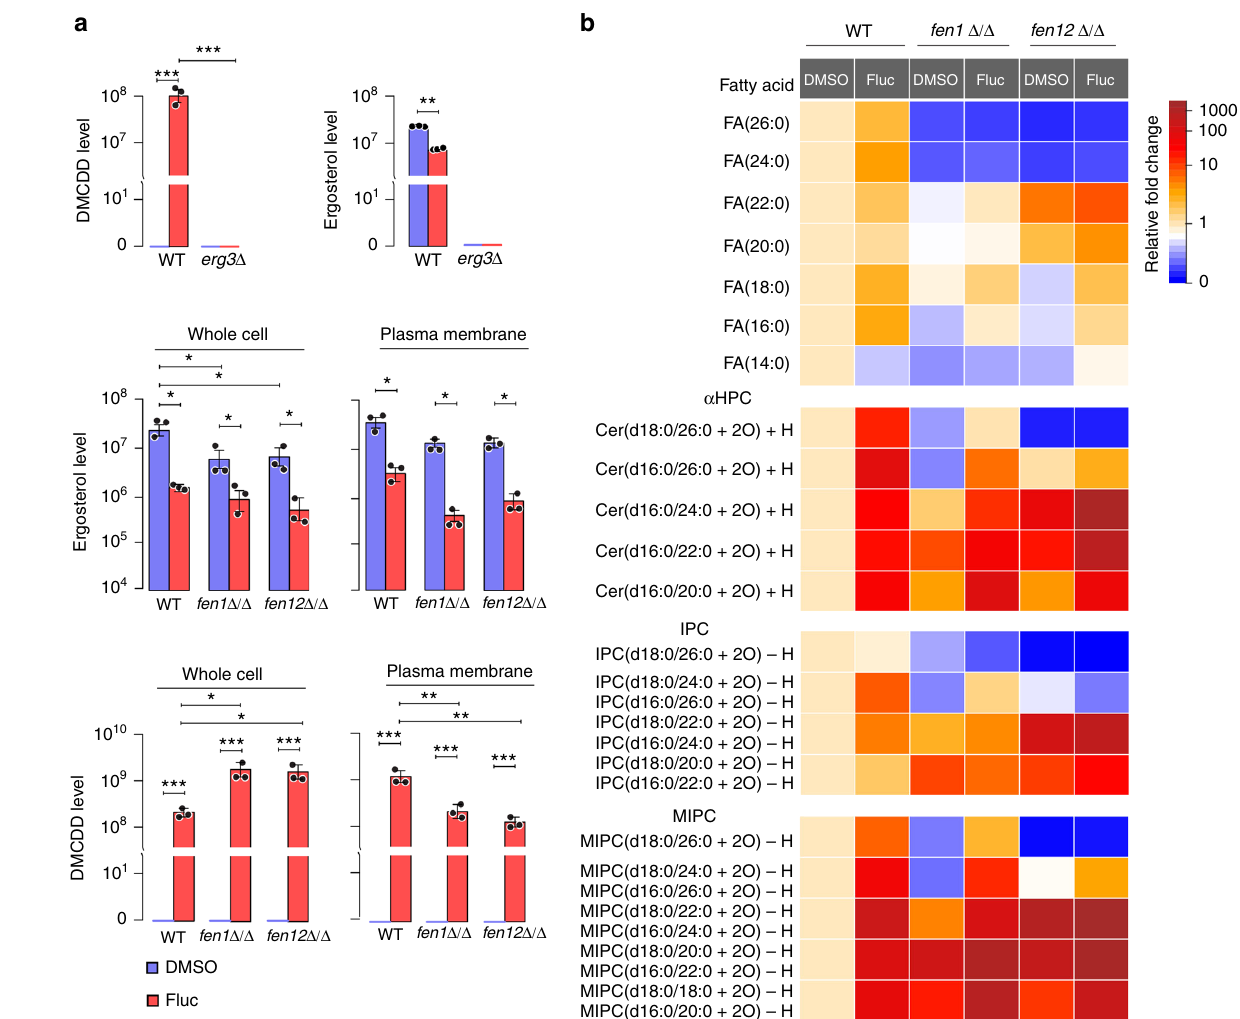
Fig. 5 LC-MS analysis of sterols and lipids in WT and fen Δ / Δ cells. a LC-MS comparison of ergosterol and DMCDD levels in whole cell lysates and the plasma membrane fraction of WT (GZY803 and BWP17), erg3 Δ , fen1 Δ / Δ , and fen12 Δ / Δ cells with or without fl uconazole treatment. Error bars represent s.d. from the mean of three independent experiments. Signi fi cance was measured using unpaired t -test (* p < 0.05, ** p < 0.01, *** p < 0.001). b LC-MS analysis of free fatty acids, α HPC, IPC, and MIPC sphingolipids in WT, fen1 Δ / Δ , and fen12 Δ / Δ cells with or without fl uconazole